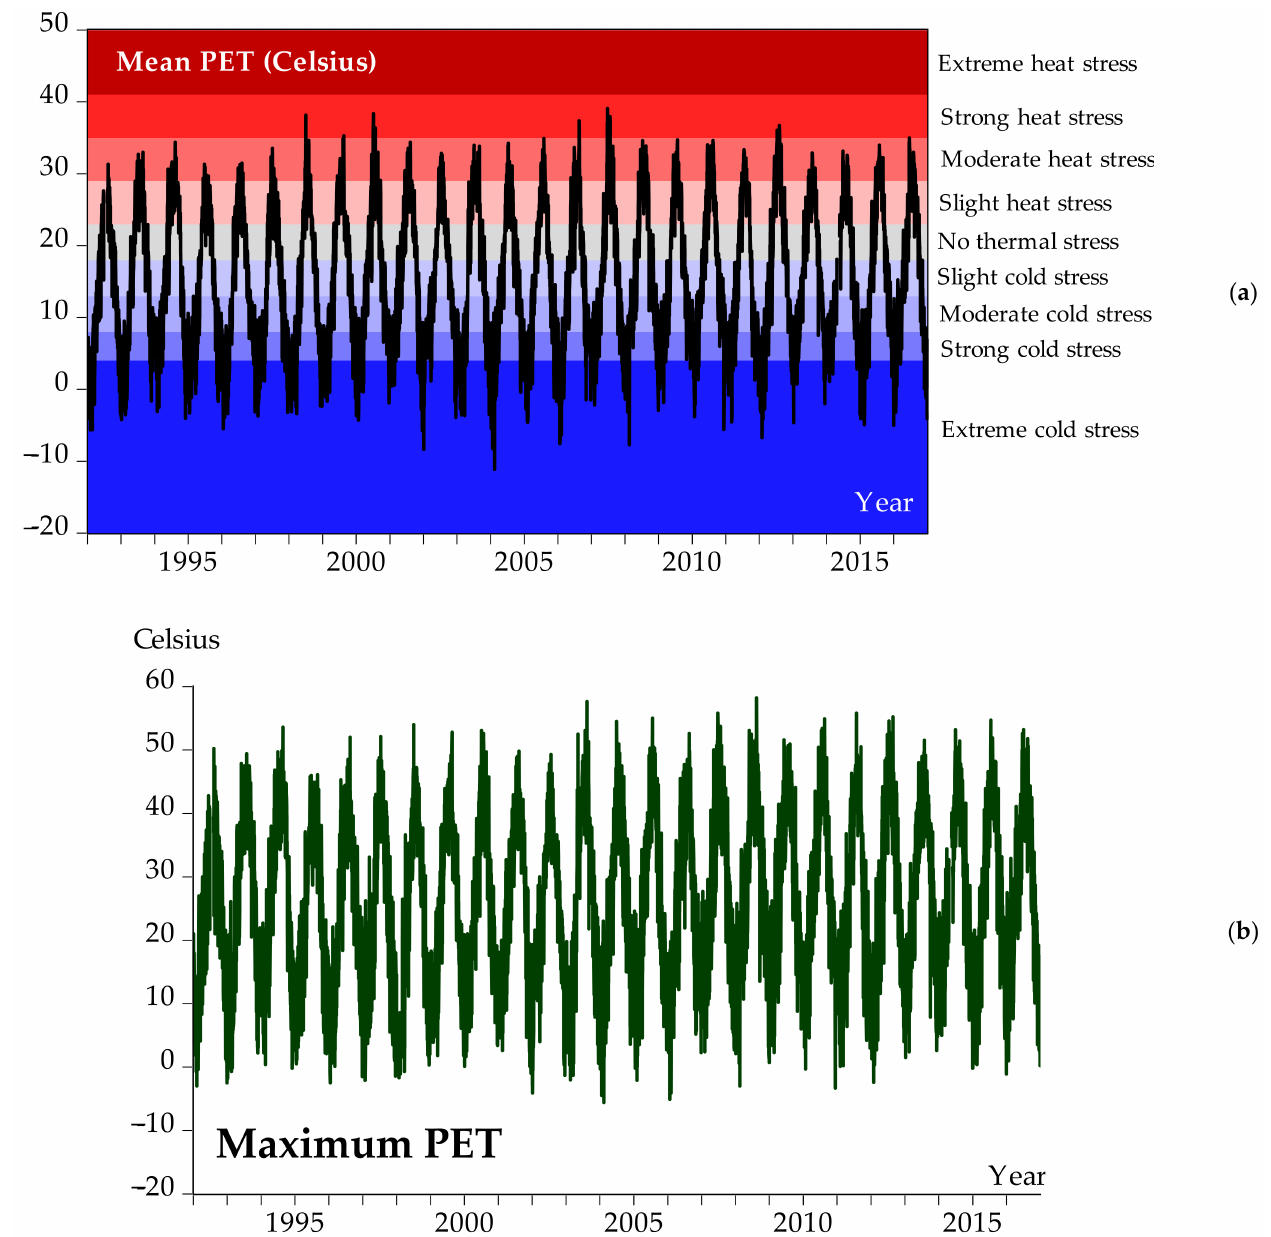
Figure 3. PET graphs of mortality for Attica: ( a ) Graph of mean PET; ( b ) graph of maximum